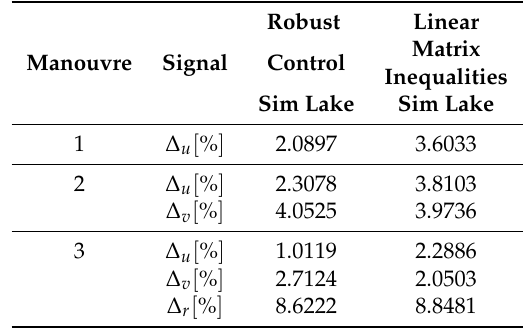
Table 4. Comparison of mean deviation values after a time when received values are diffrent from given values describe in